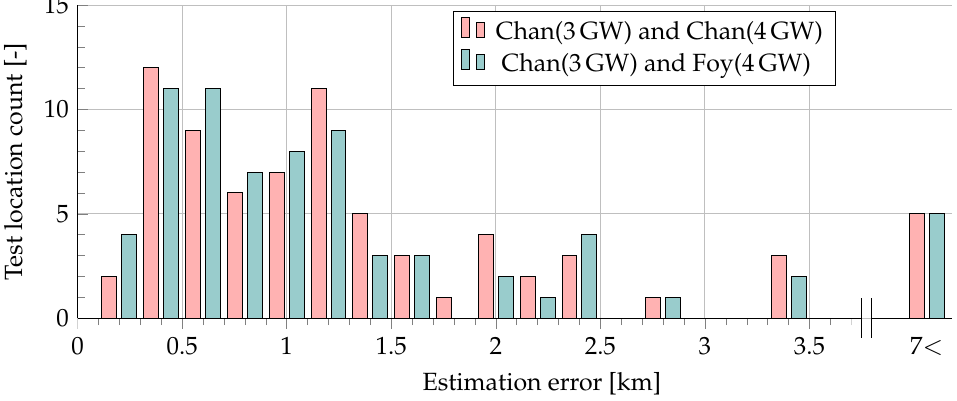
Figure 11. Comparison of raw estimation results (3 and 4 GWs) using Chan’s and Foy’s algorithms.